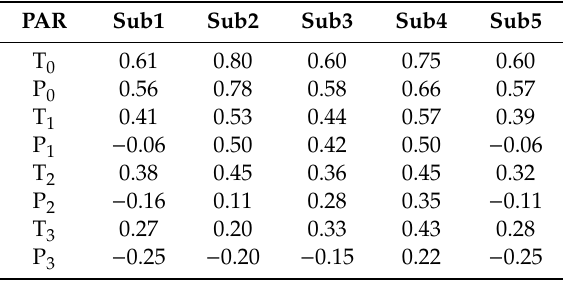
Table 5. Partial correlation calculation results.